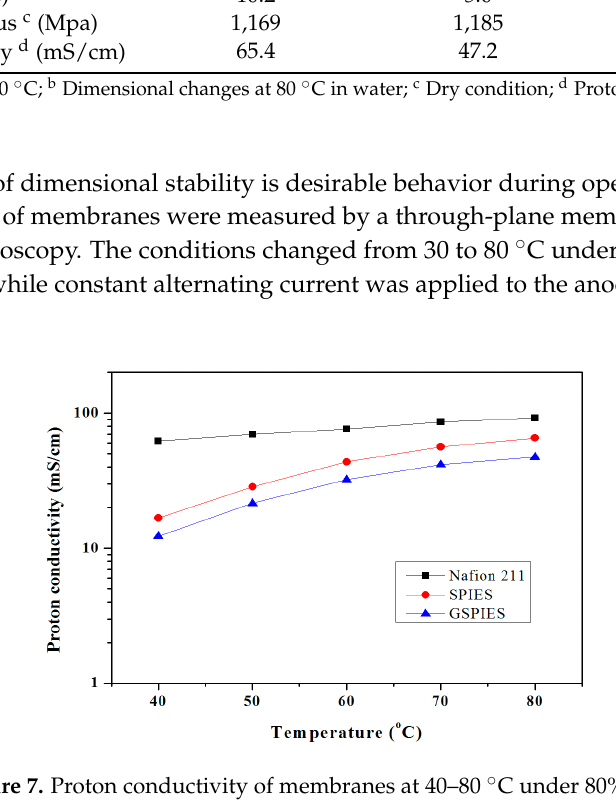
Table 1. Properties of sulfonated and grafting polymer and Nafion211 ® .